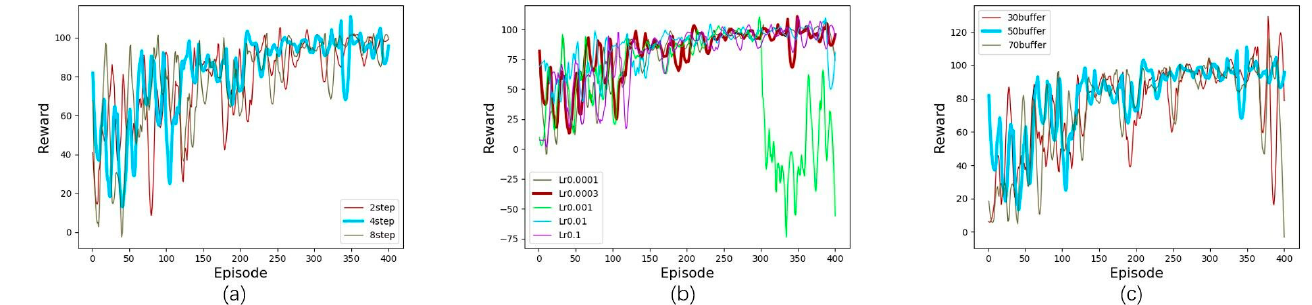
Figure 3. Effect of learning parameters: ( a ) the traffic intensity is 100%; ( b ) the traffic intensity is